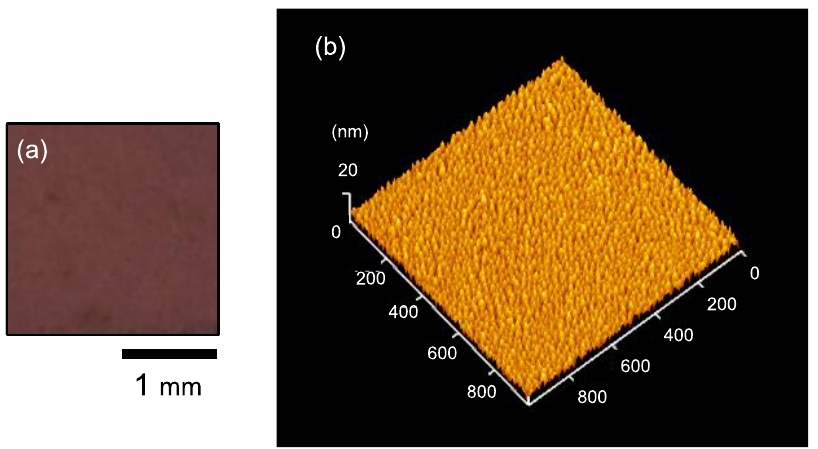
Figure 1. ( a ) A photograph of as-prepared Ag/SiO 2 ; ( b ) and an atomic force microscopy (AFM) image of as-prepared Ag/Si sample that was aged in vacuum for 7 days.